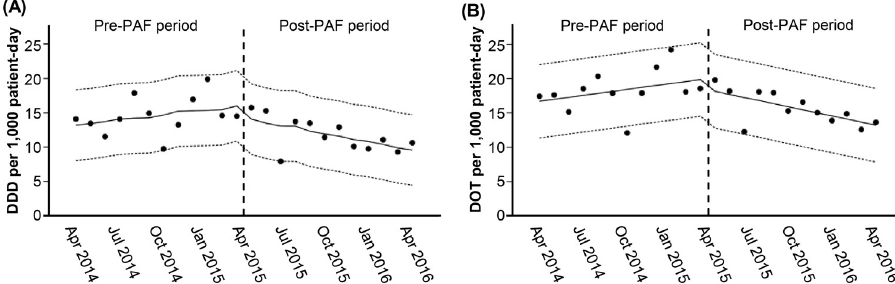
Fig 5. Effect of PAF implementation on the utilization of anti-MRSA agents. Time series of monthly DDD (panel A) and DOT (panel B) per 1,000 PD for anti-MRSA agents between April 2014 and March 2016 are plotted against time. Vertical dashed lines in each panel indicate the initiation of daily PAF implementation. Filled circles indicate the individual monthly DDD and DOT. Solid lines indicate the estimated trends during the study period according to interrupted time-series analysis, and the dotted lines indicate the upper and lower limits of the 95% confidence interval. Daily PAF implementation provoked a significant reduction in trends in both DDD (–0.65, 95% CI, –1.20 to – 0.11, P = 0.029) and DOT (–0.74, 95% CI, –1.33 to –0.15, P = 0.024) of anti-MRSA